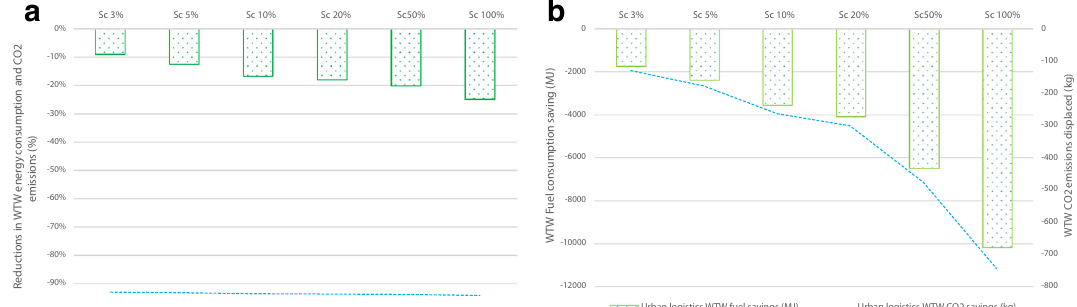
Fig.5 WTWenergyconsumption(MJ)and CO2emissions(kg)impacts: a overall network; b urban logistics vehicles. Green bars refer to WTWenergy consumption result, while blue line refers to WTW CO2